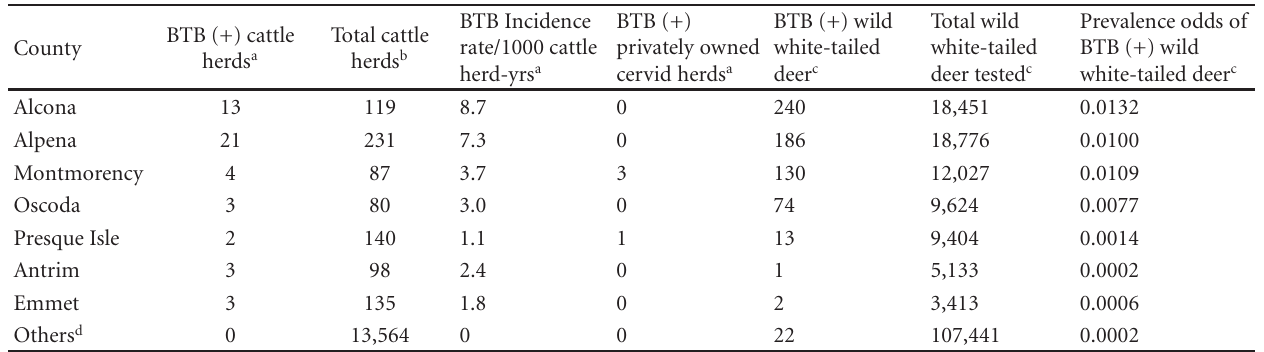
Table 1: Descriptive epidemiology of BTB in MI cattle, privately owned and wild white-tailed deer (1975–July 2010). County